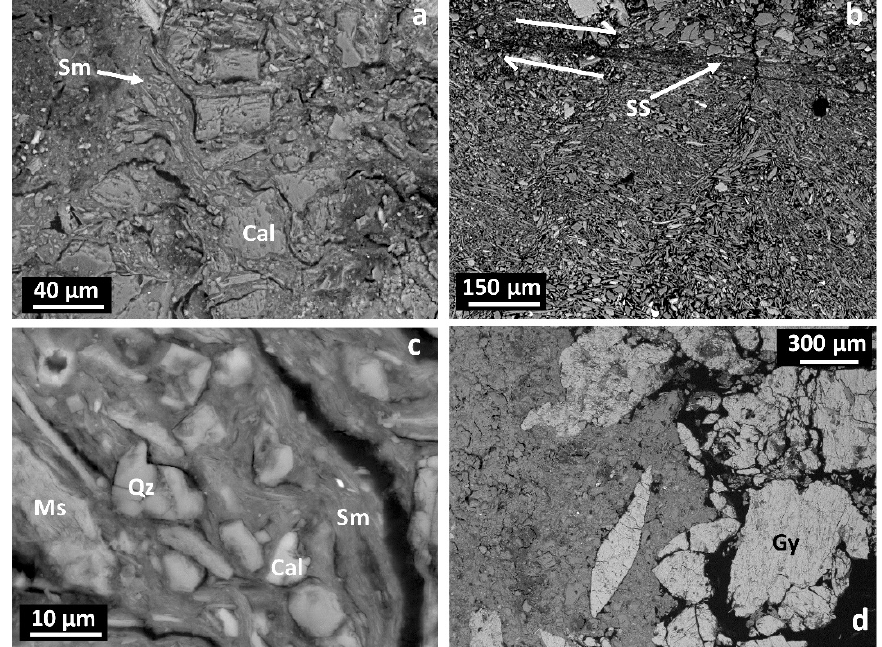
Figure 8. BSE images of dark clay sediments. ( a – c ) Clay smearing bands with evidence of flow, reorientation and extrusion produced by deformation. ( d ) Gypsum sealing of the band. Cal: calcite, Sm: smectite; Gy: gypsum, SS: Slip surfaces, Ms: muscovite, Qz: Quartz.